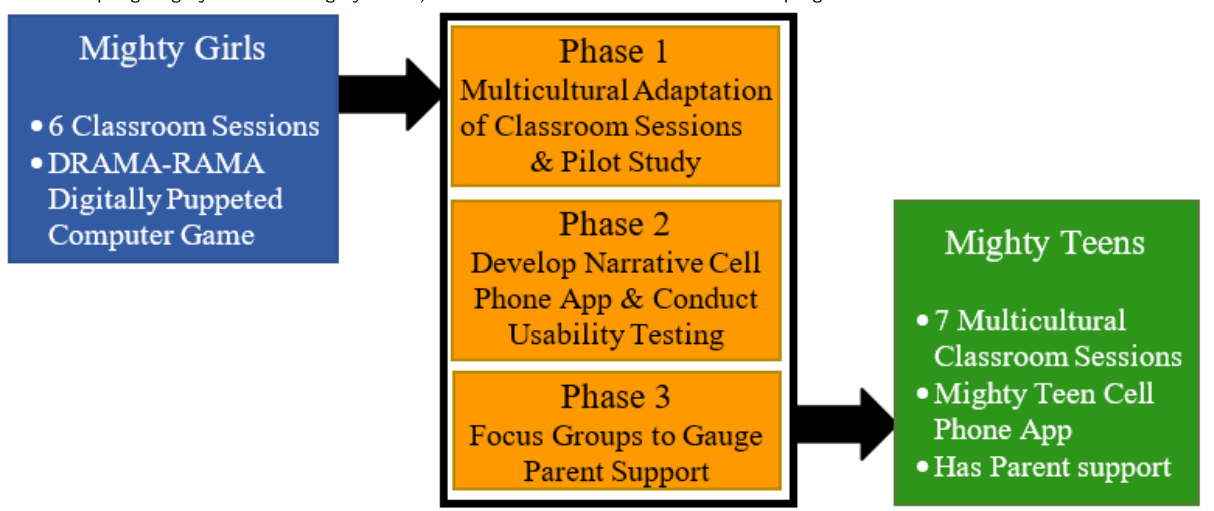
Figure 1. Adapting Mighty Girls into Mighty Teens, a more scalable and easier to disseminate